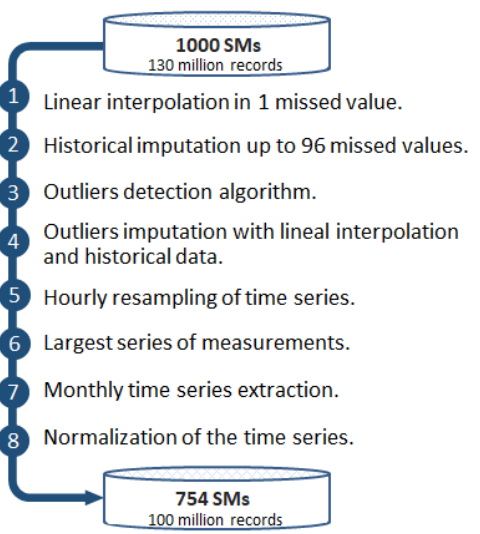
Figure 2. Flow diagram showing raw data moving to prepared